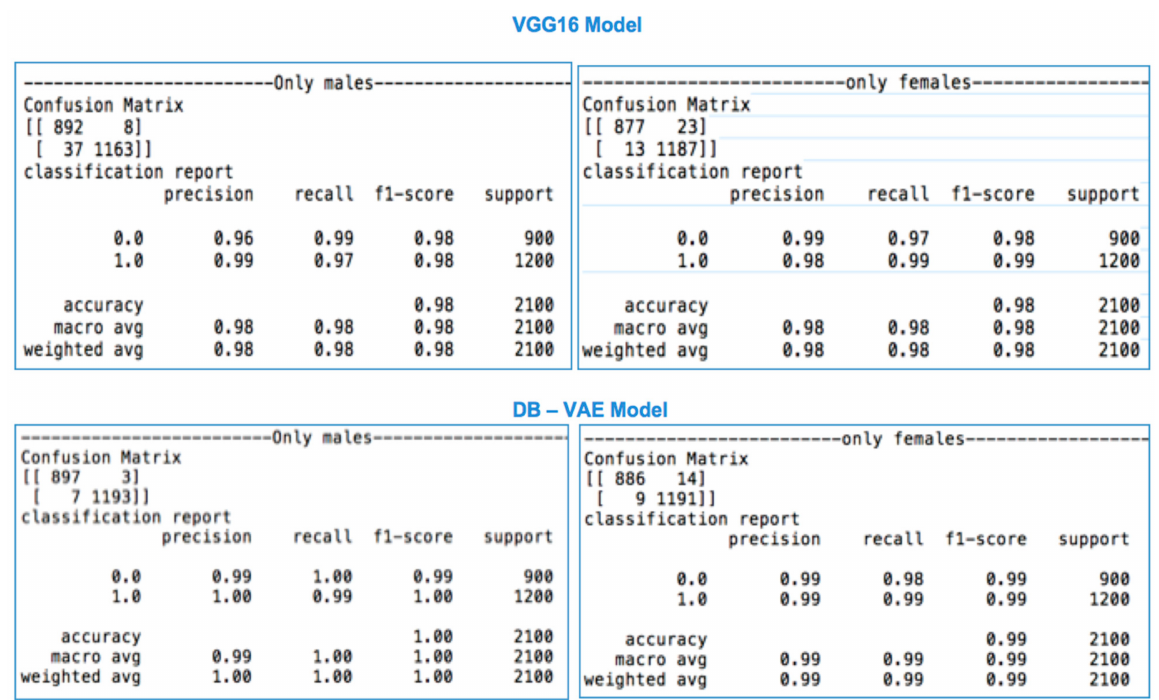
Figure 14. Evaluation of probabilities of spoof face detection per gender.